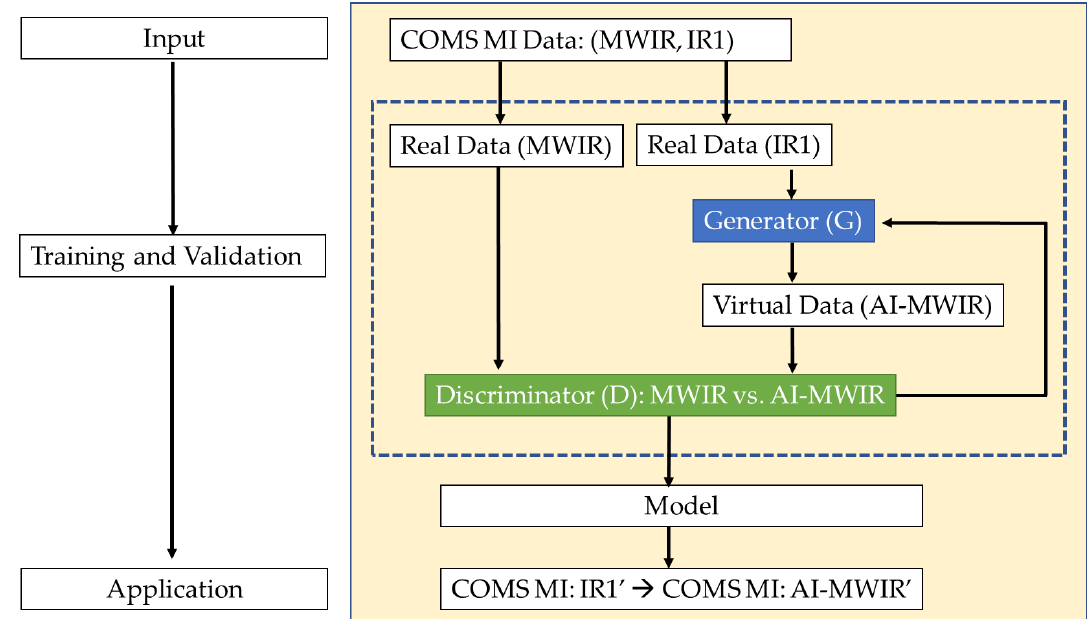
Figure 4. CGAN-based model structure in this study.